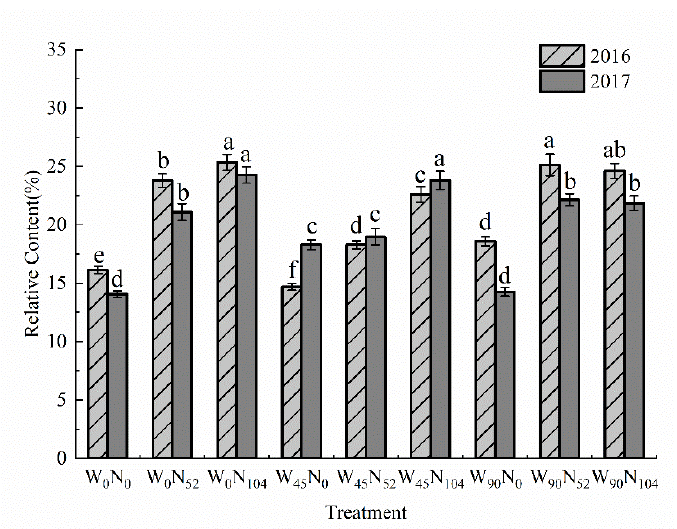
Figure 1. Influence of irrigation, nitrogen, and the interaction between the two on protein content of sunflower seed kernels (means ± SD; different lowercase letters indicate that there are significant differences in nine treatments at the 5% level in 2016 and 2017, respectively).